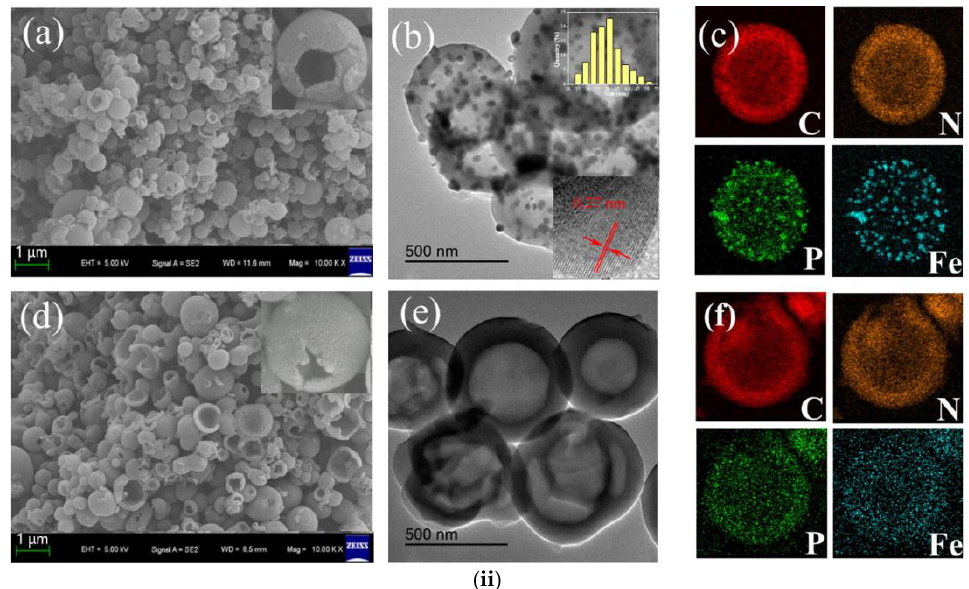
Figure 7. ( i ) Schematic diagram illustrating the synthesis of tri-doped hollow nanospheres (carbon atoms–brown, hydrogen atoms–white, nitrogen atoms–blue, phosphorous atoms- ?, oxygen atoms– red, iron atoms–orange, iron-phosphorous nanoclusters–purple). ( ii ) ( a ) Scanning electron microscopy (SEM), ( b ) transmission electron microscopy (TEM), and ( c ) energy-dispersive X-ray spectroscopy (EDS) images of the materials synthesized via simultaneous addition of precursors; ( d ) SEM, ( e ) TEM, and ( f ) EDS images of the material synthesized via the two-step procedure. Reproduced with permission from [69]. Copyright 2021 Elsevier Inc. All rights